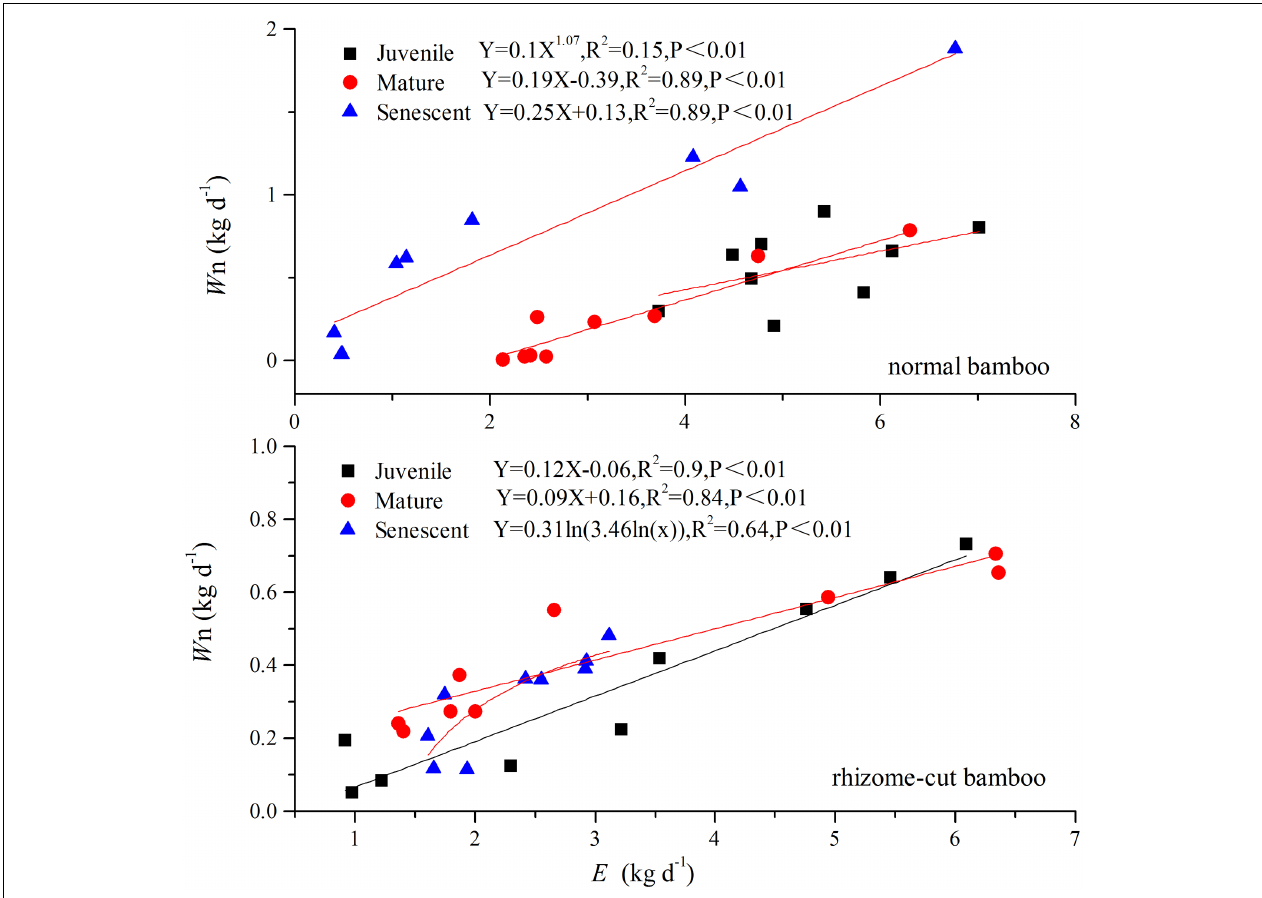
FIGURE 3 | Relationship between night-time water recharge (Wn) and total daily transpiration (E) (n =